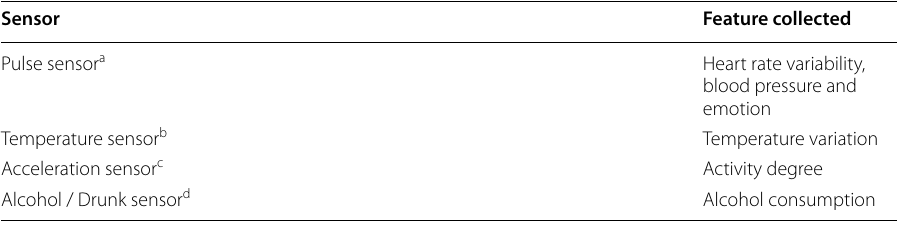
a Heart rate sensor pulse sensor for Arduino Raspberry Pi